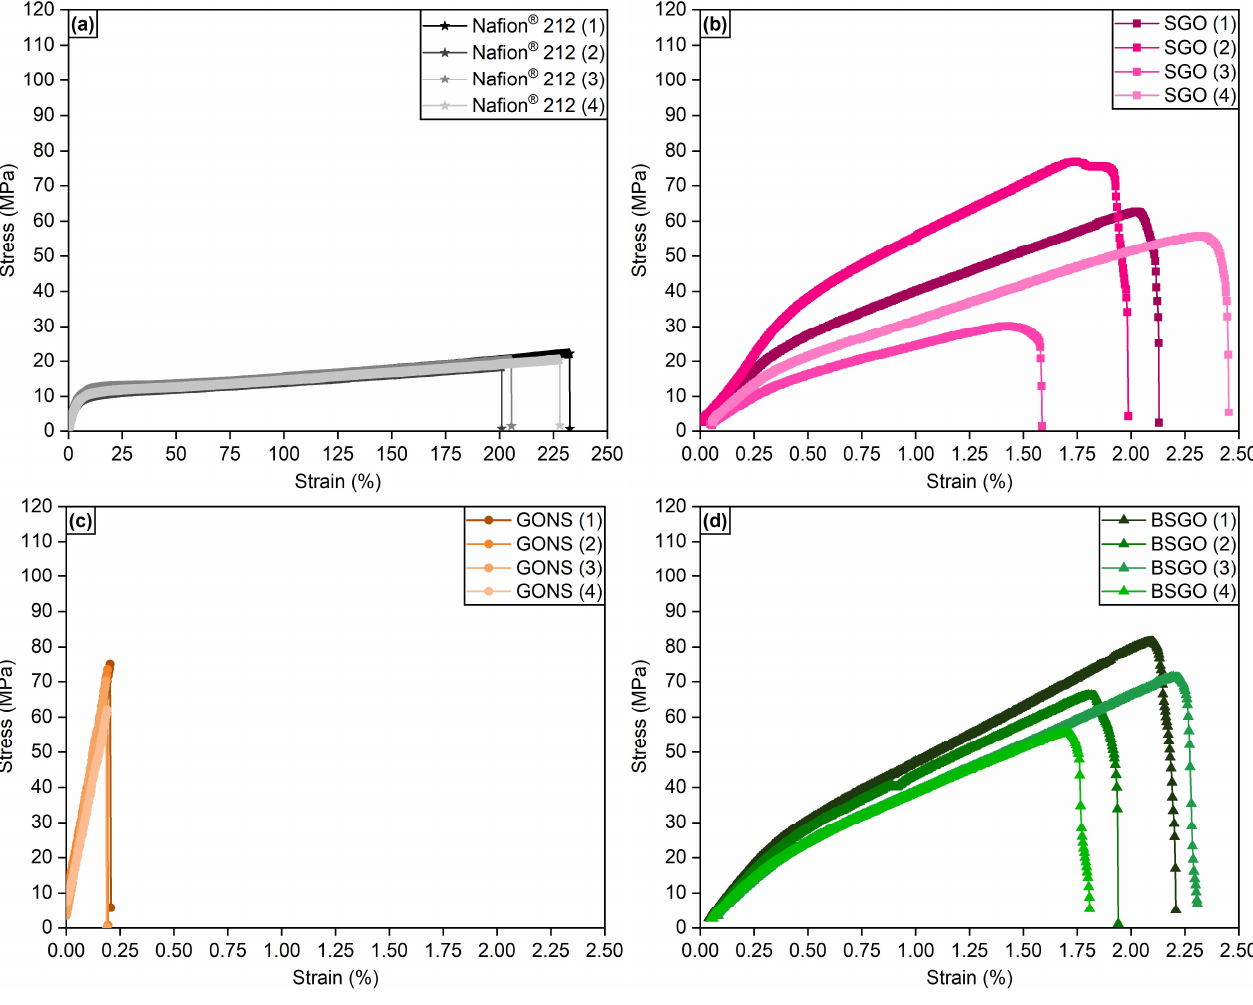
Figure 7. Stress–strain curves of ( a ) Nafion ® 212, ( b ) SGO, ( c ) GONS, ( d ) BSGO.